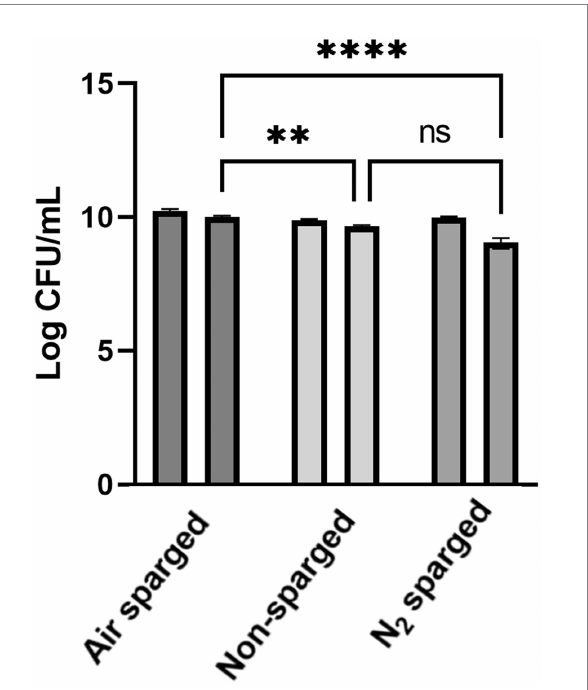
FIGURE 4 Reduction in cell count after freeze-drying FD stress. Two bars for each condition represents one for cell count before FD and other for cell count after FD. Statistical significance was calculated on FD survivability using two-way ANOVA (Tukey’s multiple comparisons test): ns, not significant, ** indicates value of p < 0.01, **** indicates value of p < 0.0001. Data are mean ± SD of three biological replicates for three